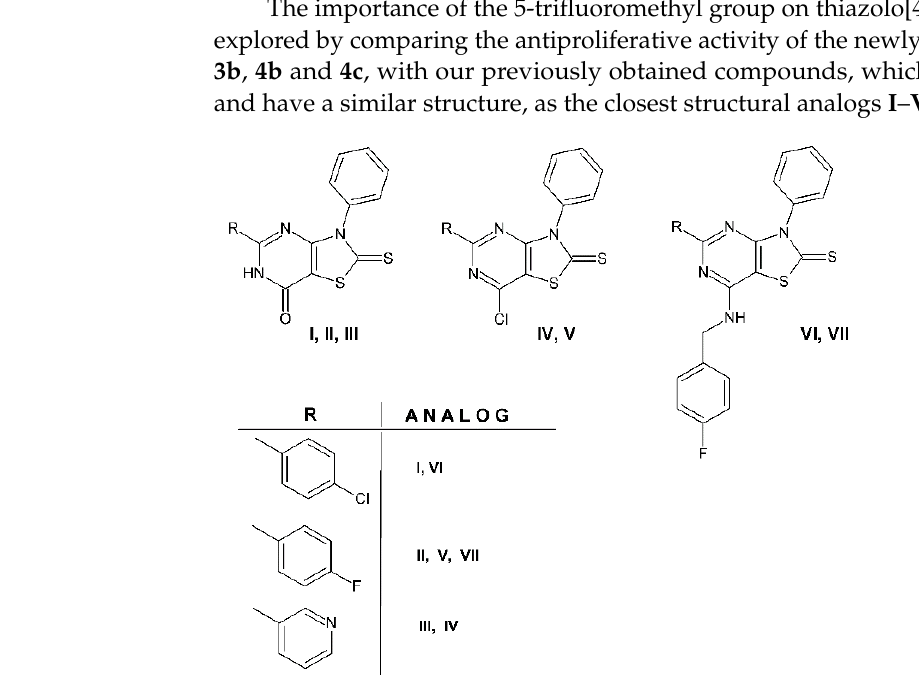
Figure 7. Structural analogs I – VII of new compounds 2b , 3b and 4c .